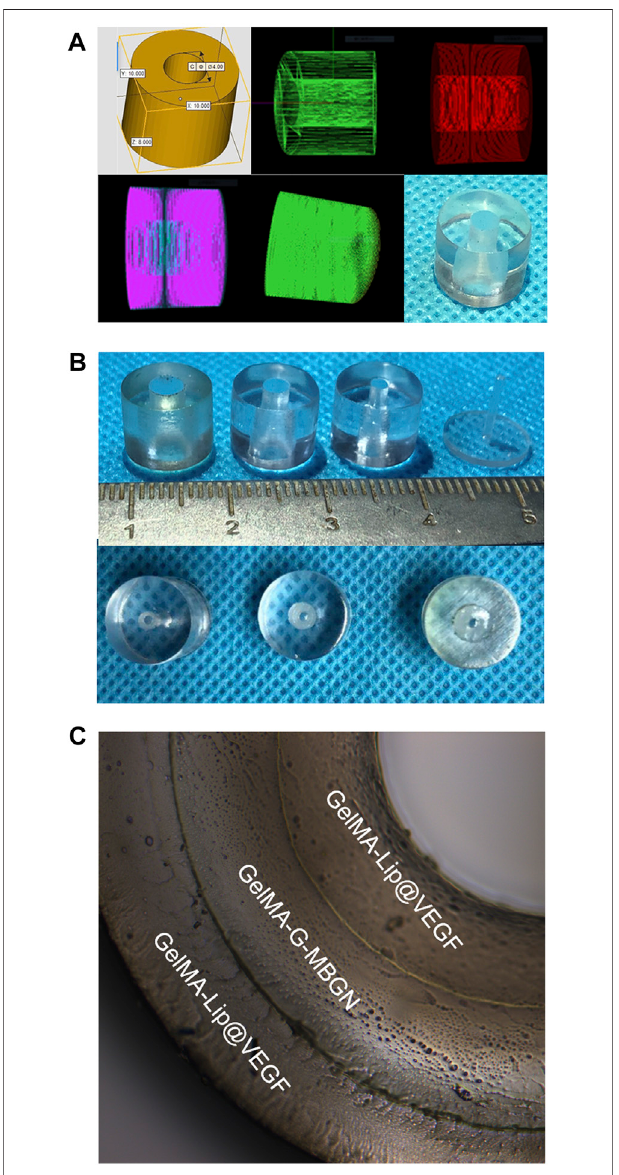
FIGURE9| Preparationofthe3Dprintmoldandstructuredscaffold. (A) Thedigitallyprogrammedshapeofthe3Dprintmold. (B) Grossobservationof the molds. (C) The inner, intermediate, and outer layers of the structured